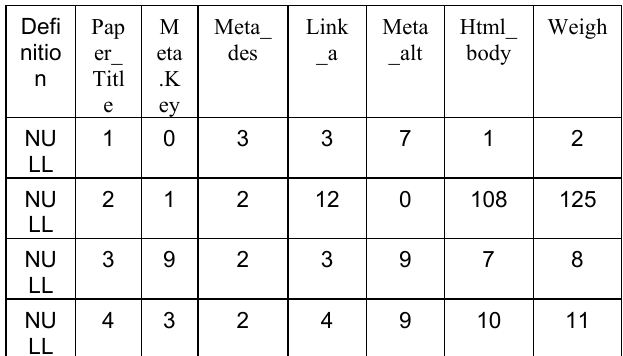
Table 6. Highest Score in textual index